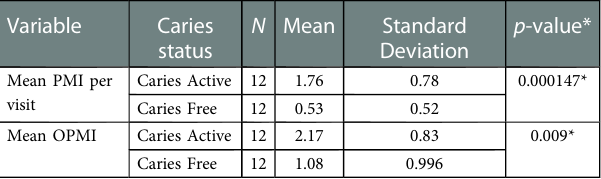
(binomial, logistic function) of association between caries status and percent of visits with a positive test (binary value=1) for each microbial measure. Results with a p -value of ≤ 0.05 were signi fi cant.